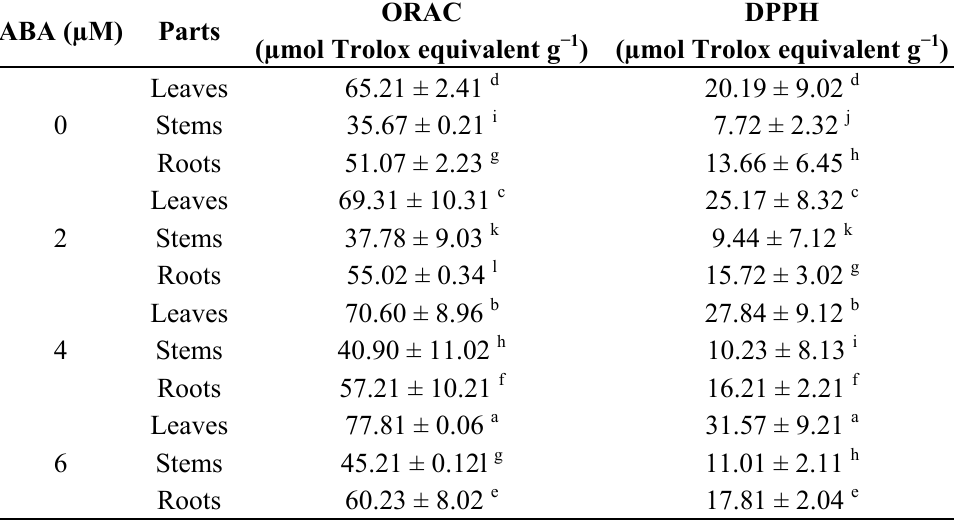
Table 5. Impact of abscisic acid levels on antioxidant capacities in different parts of Orthosiphon